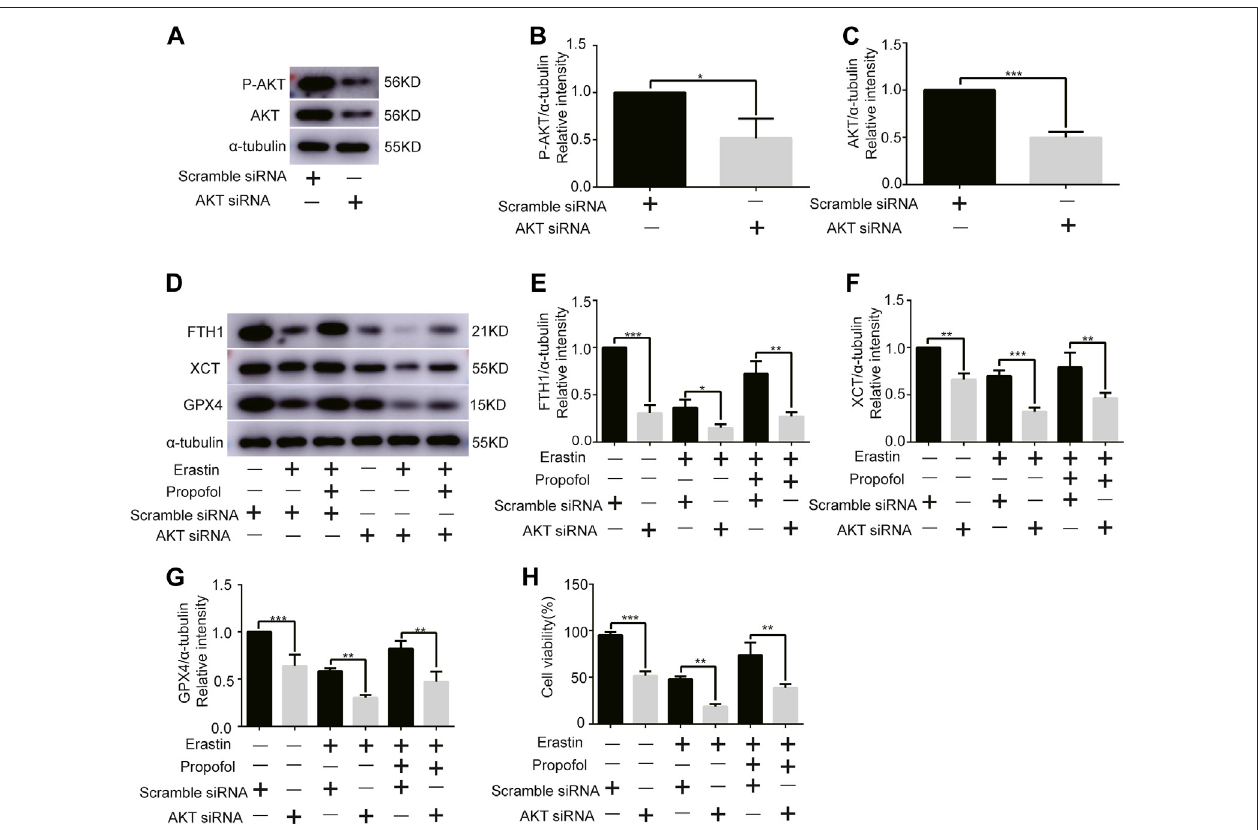
FIGURE 3 | Effect of AKT knockdown on H9C2 cell ferroptosis with propofol pre-treatment. (A – C) . Expression of AKT and p-AKT in H9C2 cells transfected with AKT and scramble siRNA. (D – G) . Levels of FTH1, XCT, and GPX4 in H9C2 cells transfected with AKT and scramble siRNA with propofol pre-treatment. (H) . Change in the viability of H9C2 cells transfected with AKT and scramble siRNA with propofol pre-treatment. N = 3. Data are expressed as the mean ± SD. Signi fi cance was calculated using one-way ANOVA with Tukey ’ s post hoc test or the t -test. p -values < 0.05 were considered statistically signi fi cant. * p < 0.05, ** p < 0.01, *** p <